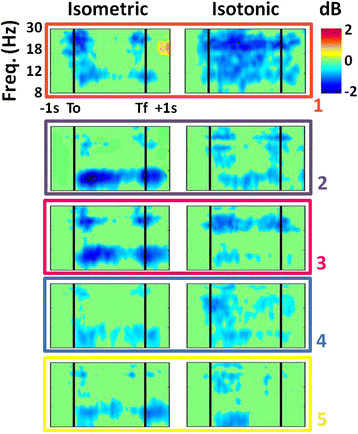
Grand average normalized spectrograms for (top row) supplementary motor area, (second row) left dorsal premotor area, (third row) right dorsal premotor area, (fourth row) posterior cingulate, and (fifth row) posterior parietal cortex showing average changes in spectral power during the task relative to a −1000 ms to −500 ms baseline for isometric (left) and isotonic (right) trials. The color of the border and the numeric label for each row corresponds to the color and numeric label of the dipoles for the corresponding cluster shown in Figure 3. The horizontal axis begins 1 s prior to trial onset (To; first black vertical line) and ends 1 s after trial offset (Tf; second black vertical line). The times between the onset and offset of the trials were warped to align these latencies across all trials. Non-significant changes from baseline (p > 0.05) were set to 0 dB (green).